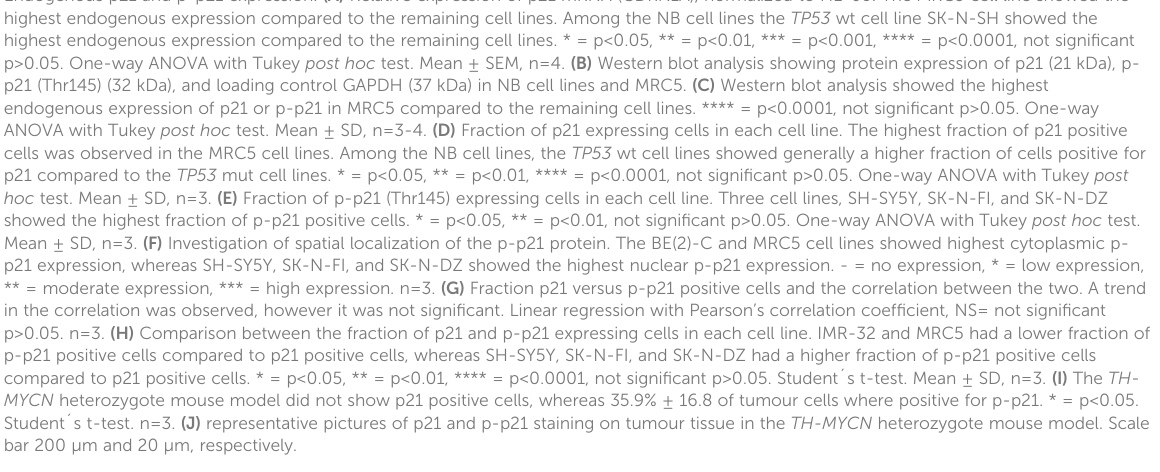
validating the speci fi city of the antibodies (Supplementary Figure S2). When further investigating the expression of p-p21, a possible trend towards a reverse correlation to p21 was observed, however this was not signi fi cant (Figure 1G). Comparing the expression of p21 and p-p21 among the tested cell lines, two cell lines, IMR-32 (14.2% ± 6.0 > 2.1% ± 2.2, p<0.05) and MRC5 (45.3% ± 2.7 > 14.0% ± 12.3, p<0.05) had a